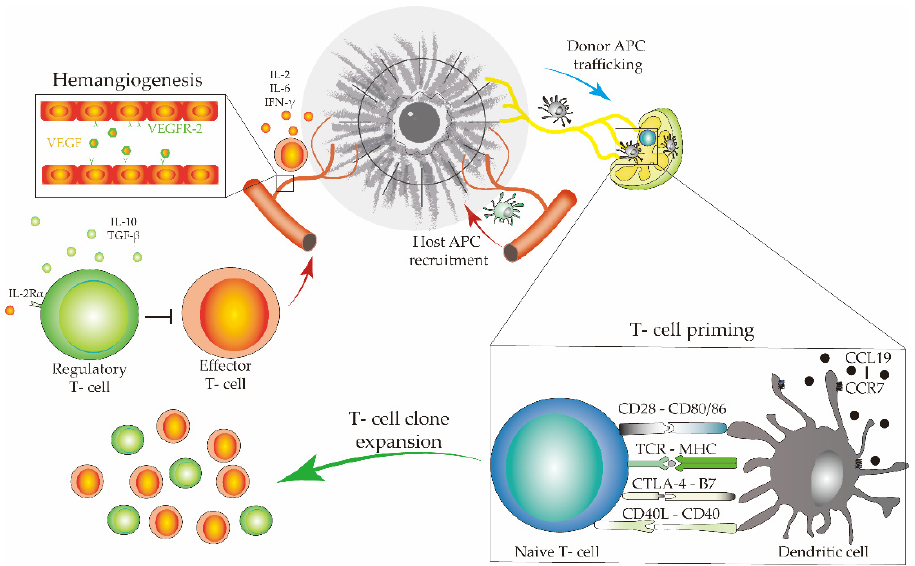
Figure 7 . Cells, cell membrane receptors, ligands, and cytokines form the immune pathway in- volved in corneal graft